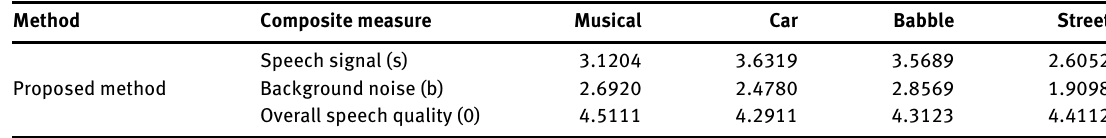
Table 13: Performance Evaluation of Combined SS-VAD and MMSE-SPZC Method Using Composite Measure for Kannada